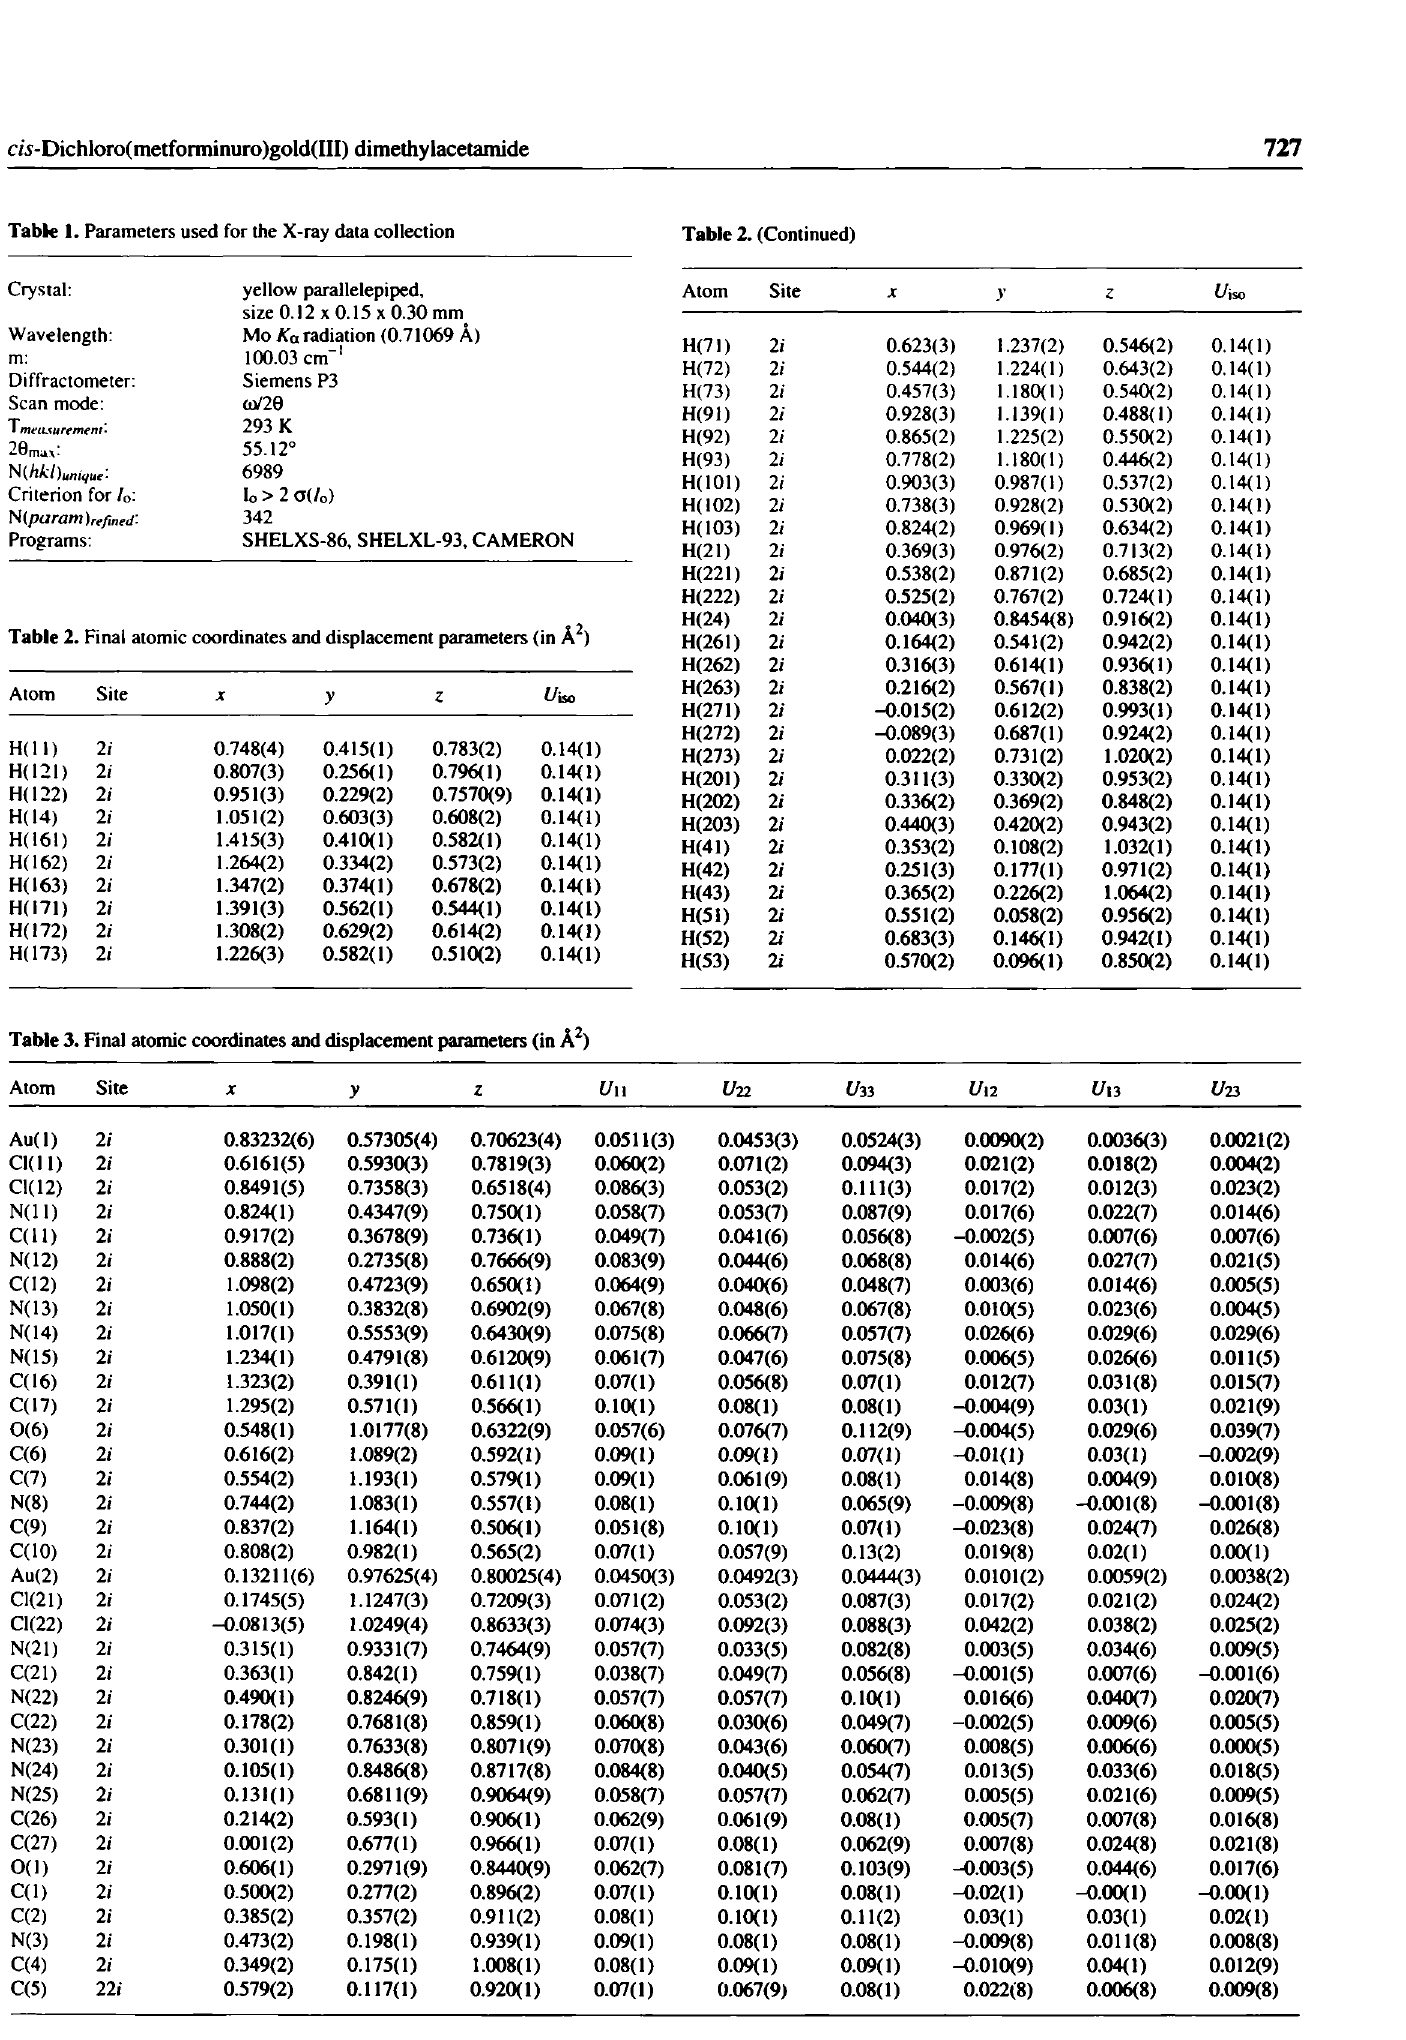
Table 2. Final atomic coordinates and displacement parameters (in Â^)